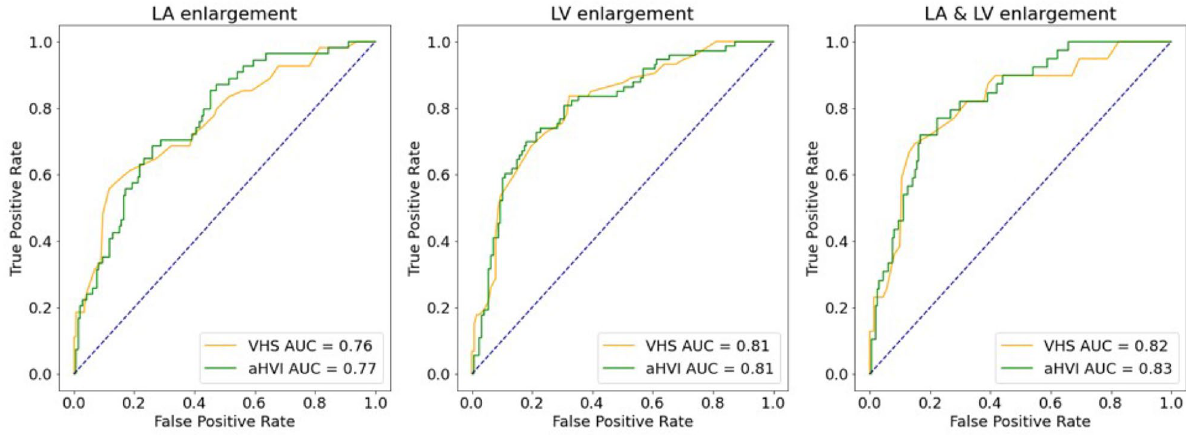
Figure 7. Area under the receiver operating characteristic (AUROC) curves of aHVI (green) and VHS (orange) in classifying left atrial enlargement (defined as LA/Ao < 1.6 and LA/Ao ≥ 1.6, left), left ventricular enlargement (defined as LVIDDN < 1.7 and LVIDDN ≥ 1.7, middle) and both left atrial and ventricular enlargement (defined as LA/Ao < 1.6 or LVIDDN < 1.7 and LA/Ao ≥ 1.6 and LVIDDN ≥ 1.7, right).